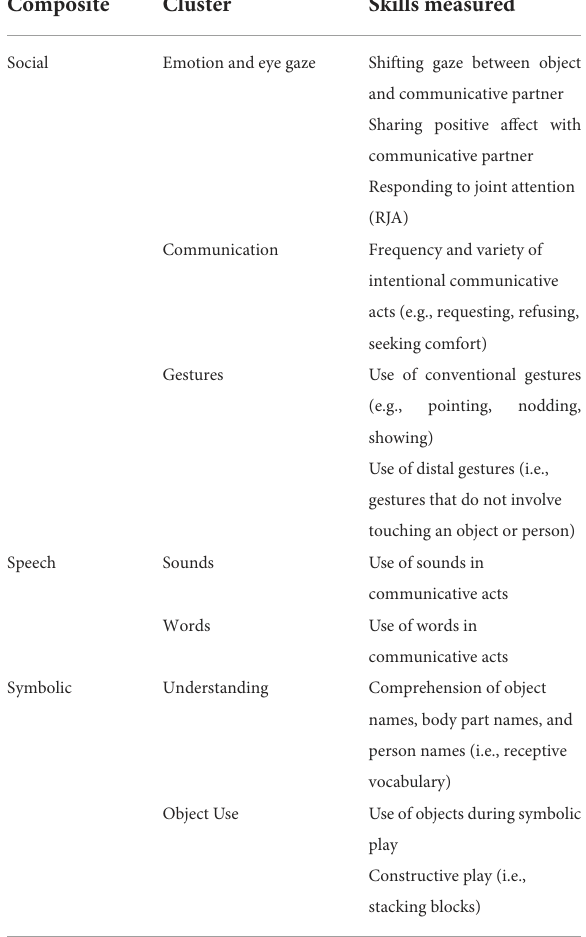
TABLE 1 Overview of social communication skills measures in the CSBS